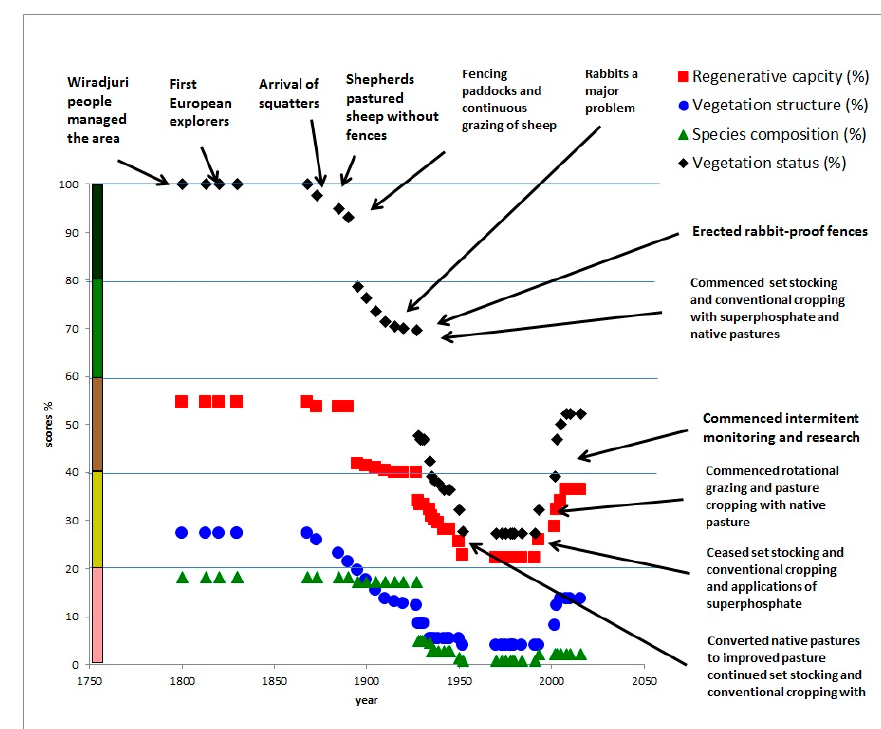
Figure 4. Case study 3: Wirilda, Harrogate, Mediterranean agro-climate region, Callitris , eucalypt low mallee woodland.